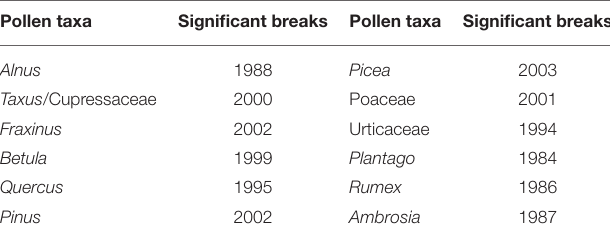
TABLE 2 | Significant breakpoints in the data series detected with the Penalized Maximal F